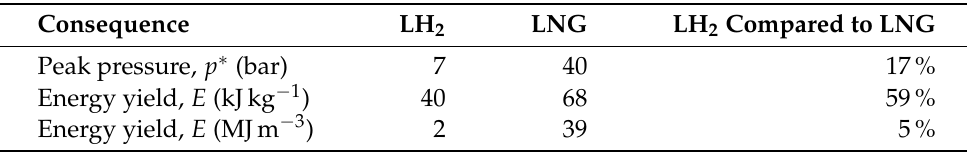
Figure 8. Thermodynamic diagram for H 2 , from triggering the initial state to the final state. Table 3. The predicted consequences of LH 2 RPT compared to LNG